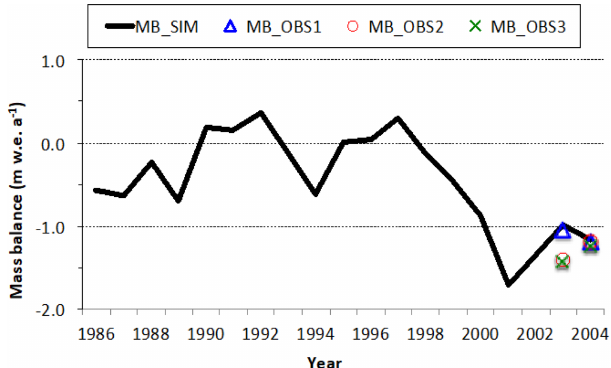
Figure 6. The simulated glacier mass balance (MB_SIM) and ob- served mass balances of the Chhota Shigri Glacier, i.e., MB_OBS1 (Berthier et al., 2007), MB_OBS2 (Wagnon et al., 2007), and MB_OBS3 (Azam et al.,